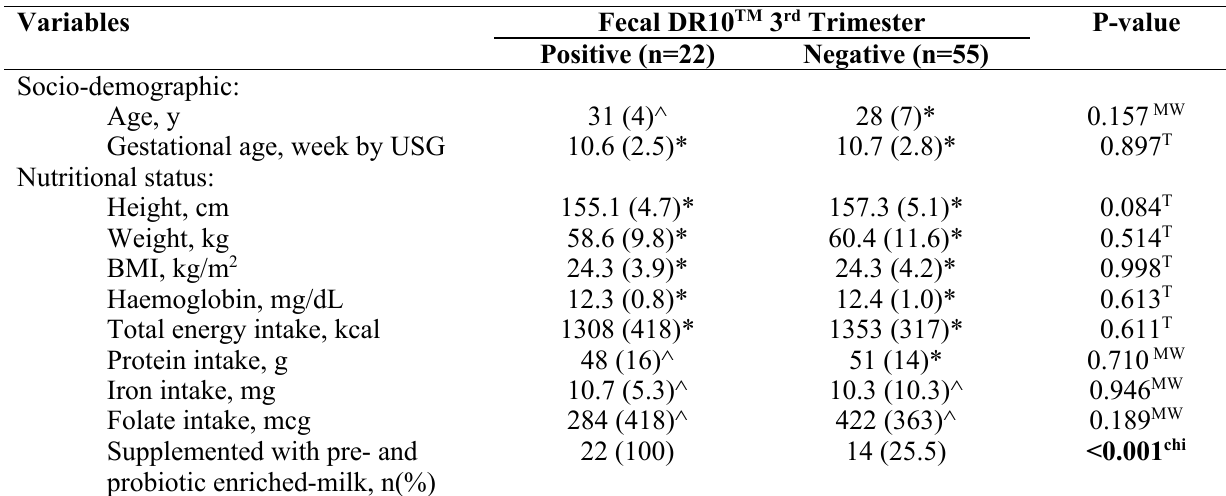
Table 1. Baseline characteristics of the subjects at first semester